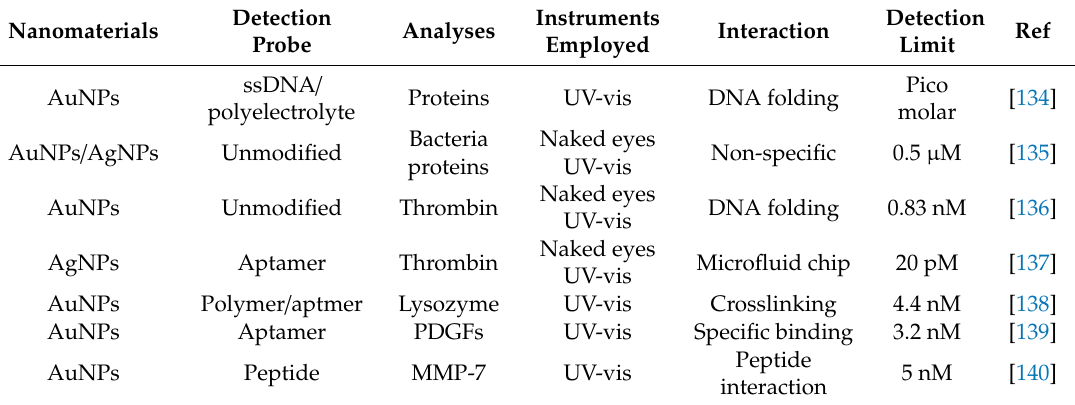
Table 4. Recent reported AuNPs / AgNPs-based colorimetric biosensors for protein detection.